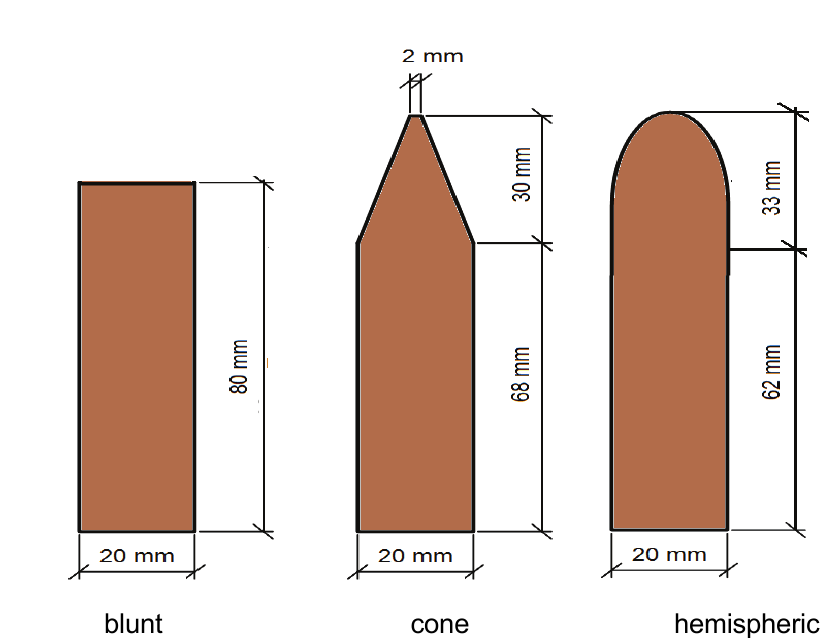
Figure 1 – Geometry and dimensions of projectiles with different tip shapes Рис . 1 – Геометрические формы и размеры снарядов с различными головками Слика 1 – Геометрија и димензије пројектила са различитим облицима